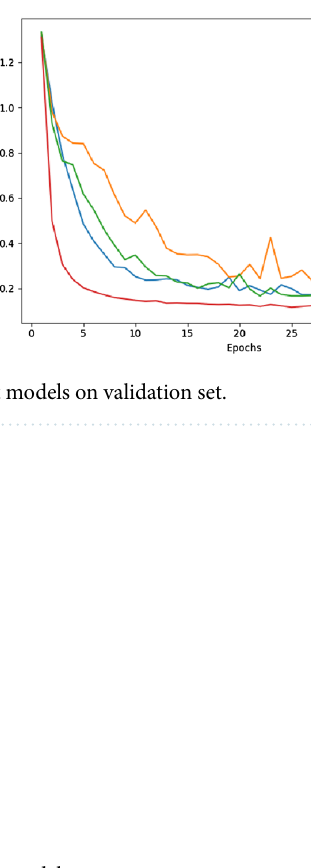
Figure 9. The accuracy and loss comparation of different models on test set.